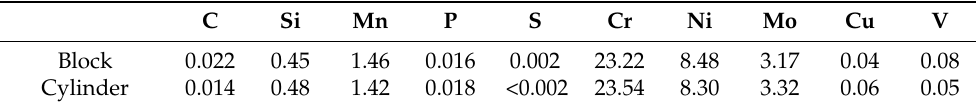
Table 5. Chemical composition of the additively manufactured components analyzed by optical emission spectroscopy (OES).